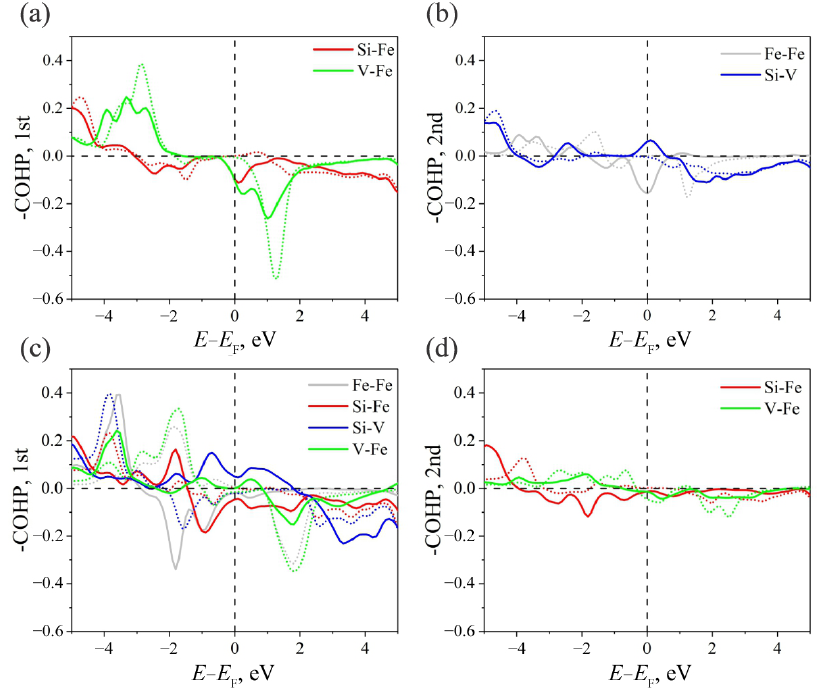
Figure 5. − COHP for ( a ) the first and ( b ) the second coordination spheres of atoms in the Fe 2 VSi Heusler alloy of structure L 2 1 . − COHP for ( c ) the first and ( d ) second coordination spheres of atoms in the Fe 2 VSi Heusler alloy of the XA structure.